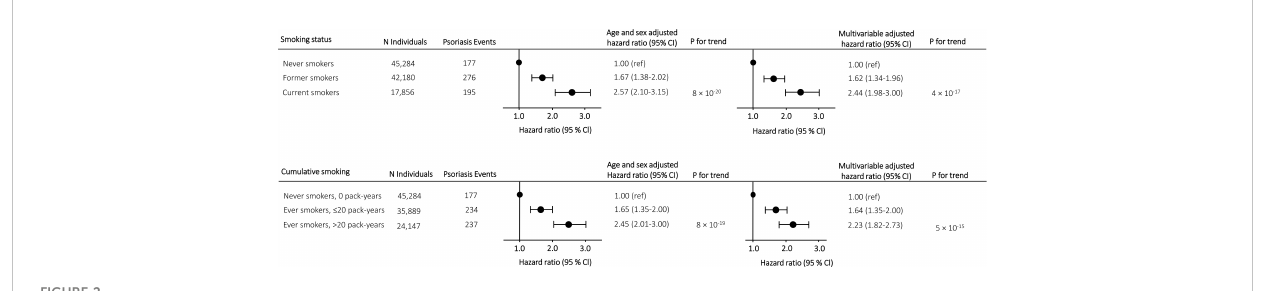
FIGURE 2 Risk of moderate to severe psoriasis according to smoking status and cumulative smoking in prospective analyses in individuals from the Copenhagen General Population Study. Hazard ratios were multivariable adjusted for age (underlying timescale), sex, BMI, hypertension,